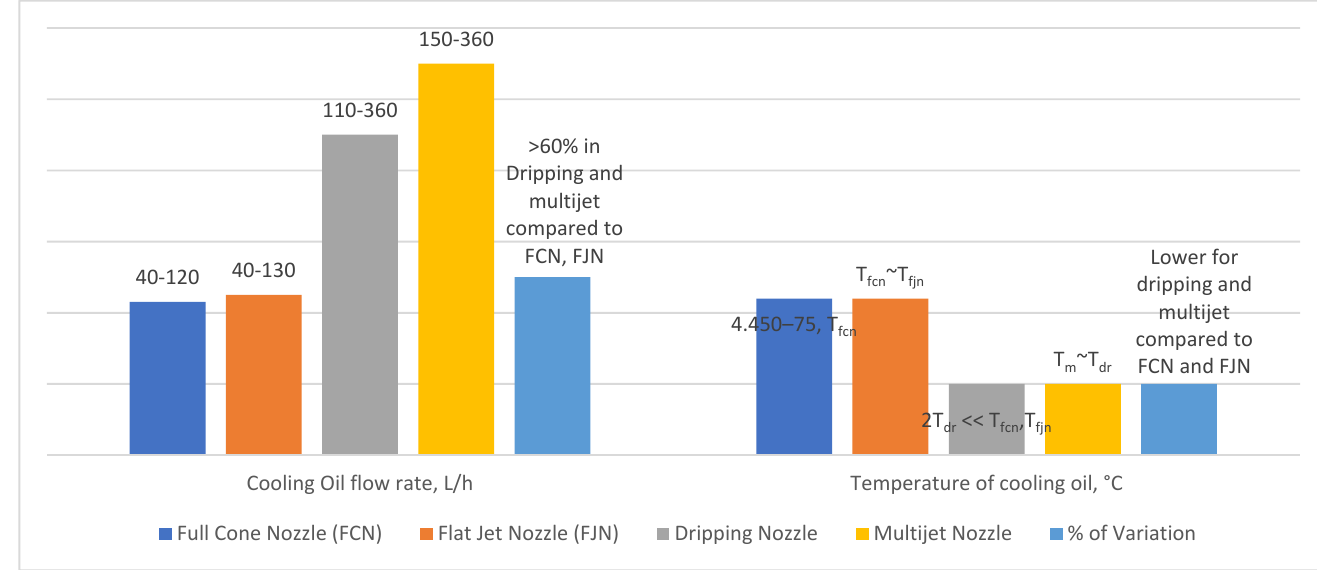
Figure 11. Different oil flow patterns: ( a ) Flat jet nozzle (FJN); ( b ) Full cone nozzle (FCN); ( c ) Dripping nozzle; ( d ) MultiJet nozzle [42].